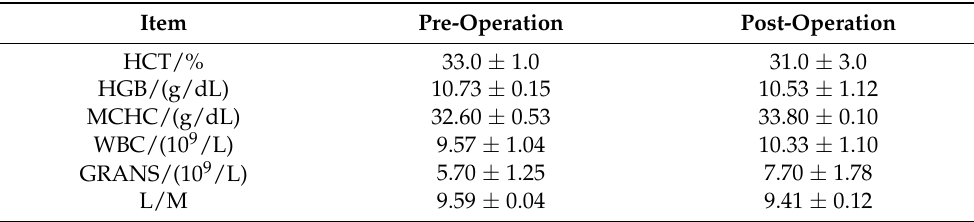
Table 1. Routine blood test results.